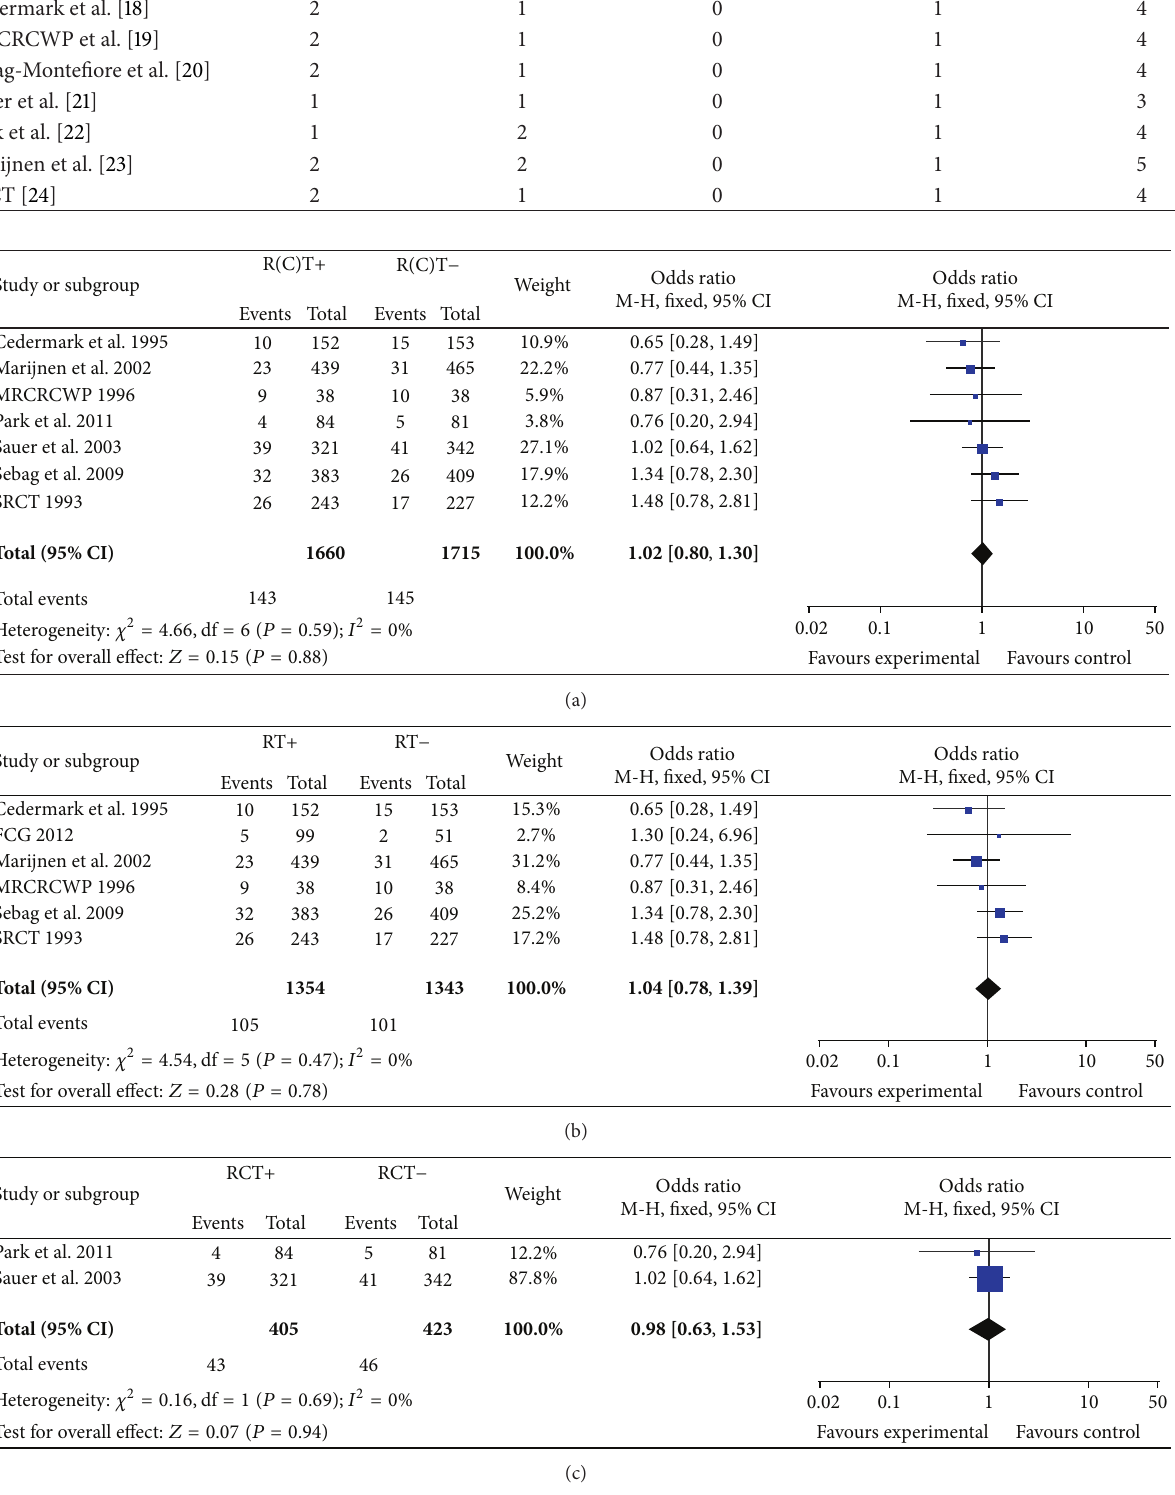
Figure 2: (a) Impact of pR(C)T on anastomotic leakage. CI, confidence interval; OR, odds ratio. (b) Impact of pRT on anastomotic leakage. CI, confidence interval; OR, odds ratio. (c) Impact of pRCT on anastomotic leakage. CI, confidence interval; OR, odds